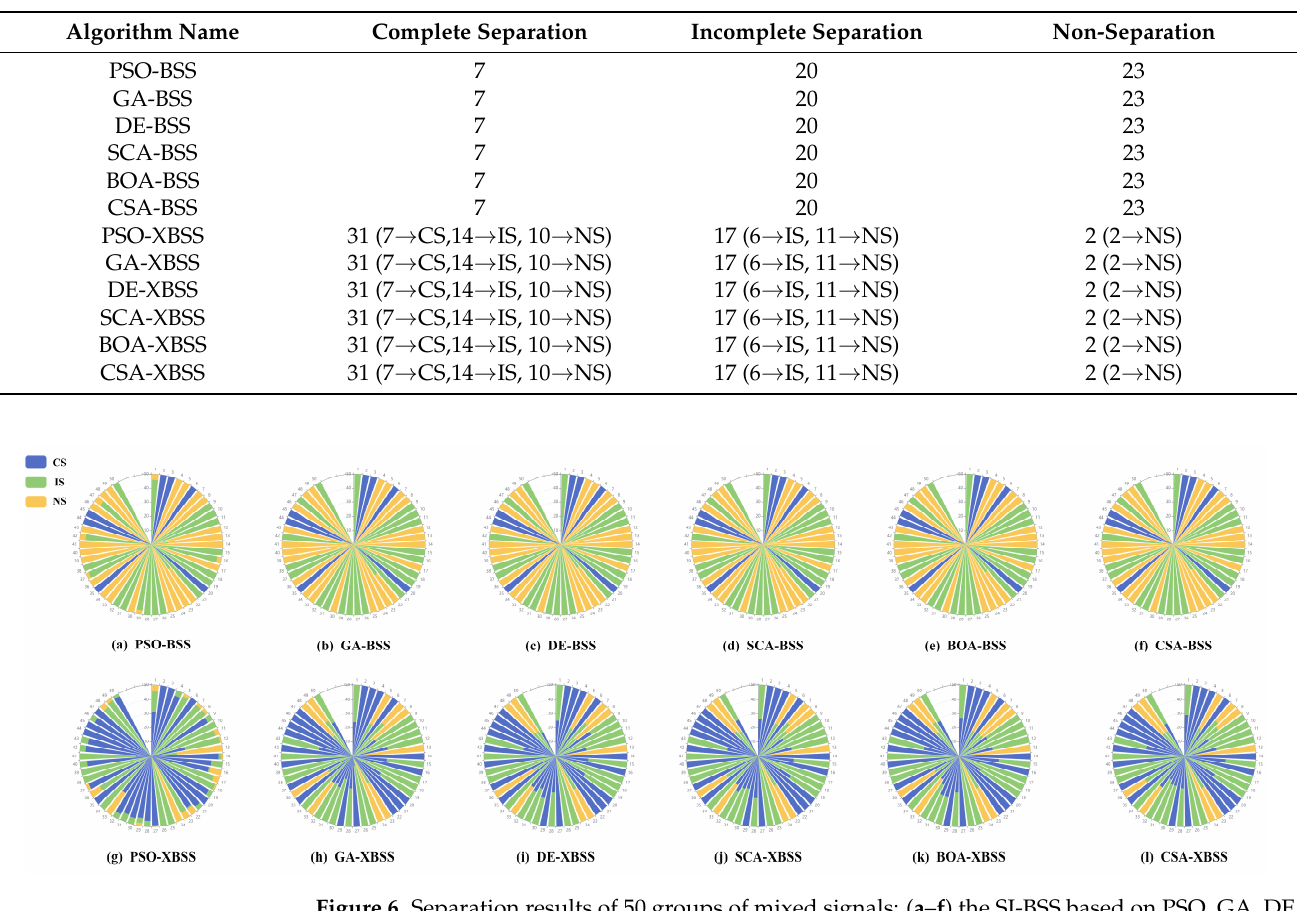
Table 1. Separation results of 50 groups mixed signals. (CS is complete separation. IS is incomplete separation. NS is non-separation. In column Complete Separation, the “14 → IS” represents that 14 groups were completely separated by SI-XBSS, which were incompletely separated by SI-BSS.).